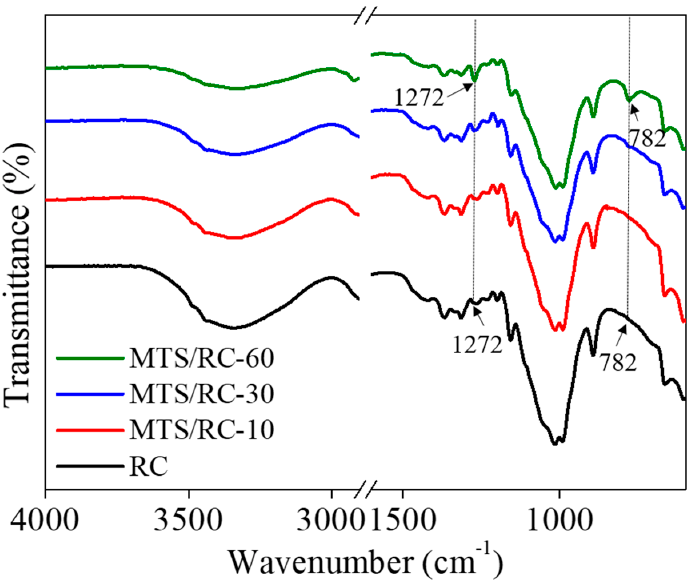
Figure 3. FT-IR spectra of the pristine RC film and the MTS/RC films with different MTS deposition times (10, 30, and 60 min).